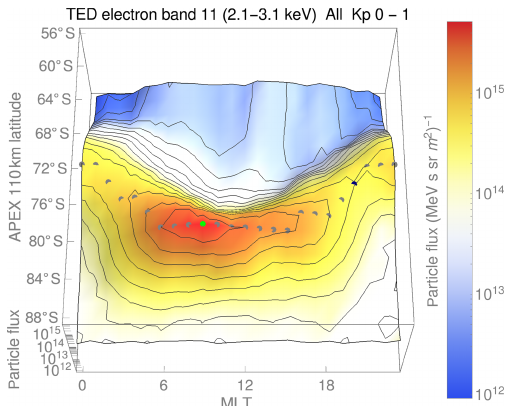
Figure 2. Sample for an auroral oval fit. The grey dots represent the position of the auroral oval. The green (9MLT) and black (20MLT) dots indicate the maximum and minimum of the auroral oval, re-